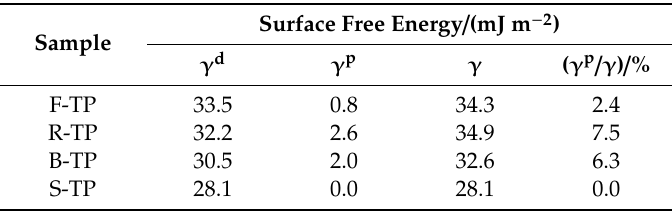
Table 7. Surface free energies of TC prints determined by OWRK method. TP–thermochromic print; ( γ p / γ ) index of